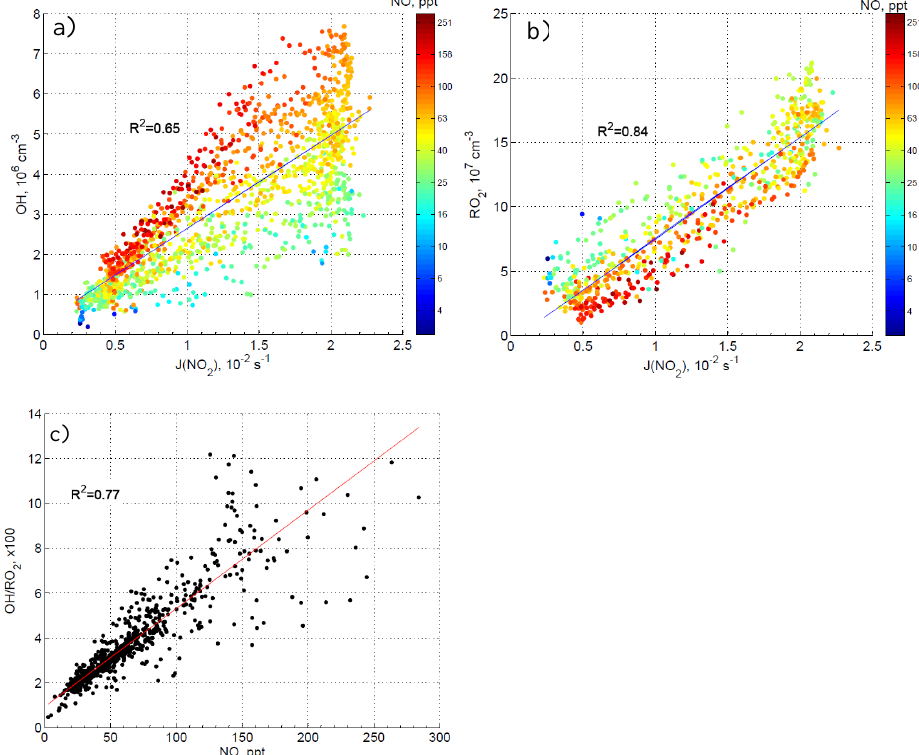
Figure 3. Correlations of [OH] (a) and [RO 2 ] (b) with J (NO 2 ) and of [OH] / [RO 2 ] with [NO] (c)